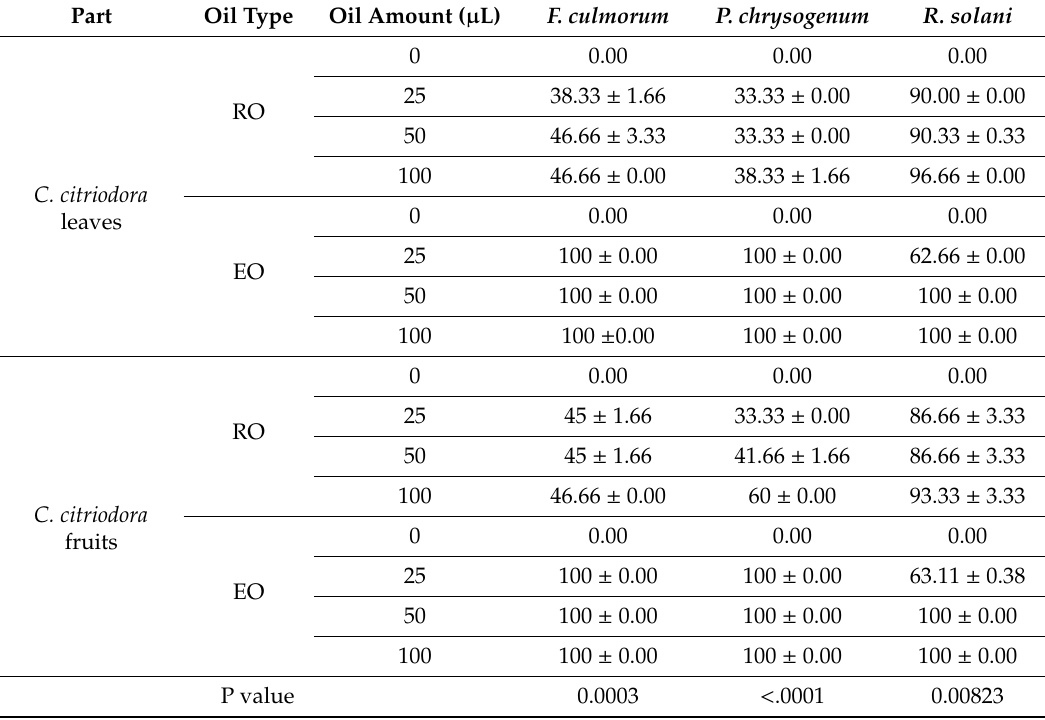
Figure 7. Overall bioactivity of C. citriodora ( a ) part source, ( b ) oil source and ( c ) oil amount against fungal linear growth of F. culmorum , P. chrysogenum and R. solani. Table 6. Inhibition percentages of fungal growth (%) as affected by wood treated with C. citriodora oils with different amounts.